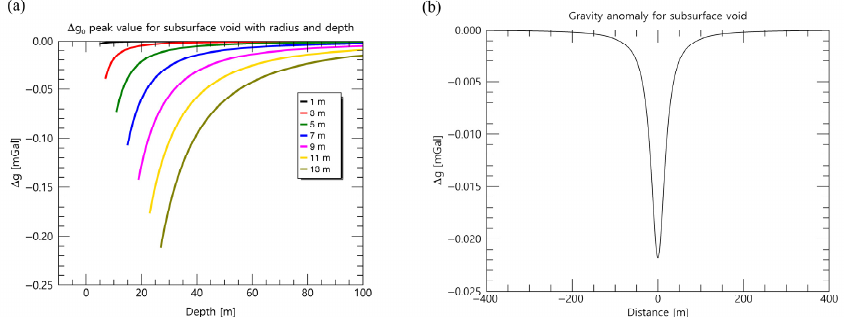
Figure 1. ( a ) Variation of gravity anomaly depending on radius and depth of lunar subsurface void. ∆𝑔 (cid:2868) is the surface above the void position where the change in gravity is strongest, and the radius is indicated in the legend by specifying the color from 1 m to 13 m (at intervals of 2 m). Lunar crustal density was set as the background density ( 𝜌 (cid:2868) = 2550 kg/m 3 ), and the density of the empty space was set as 𝜌 (cid:2868) = 0 kg/m 3 . ( b ) Gravity anomaly when an empty sphere having radius of 5 m exists at depth of 20 m. Gravity anomaly variation decreases sharply as the distance between the empty space and the surface increases and decreases by 95 % when compared to the 𝑔 (cid:2868) point at 100-m depth. Density conditions of ( b ) are same as those of ( a ).